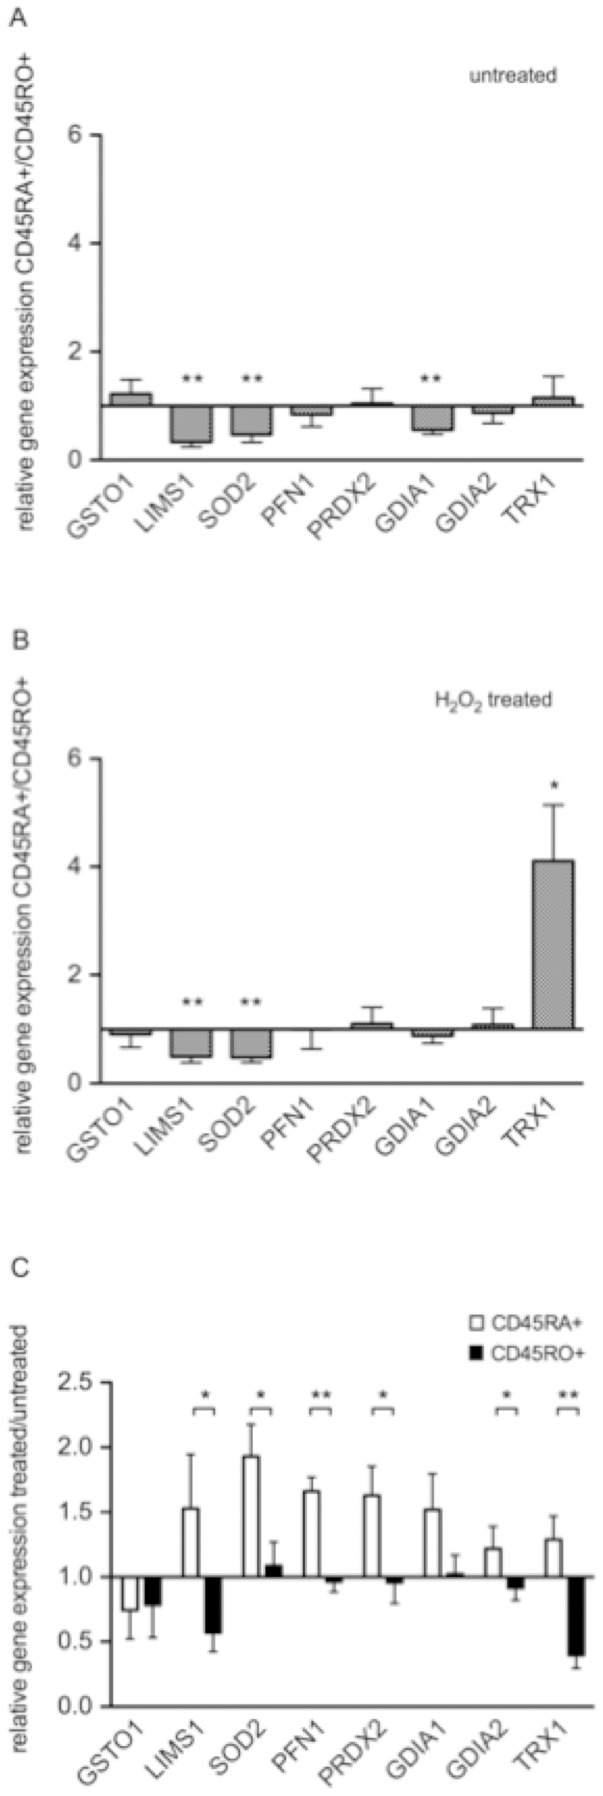
Comparative mRNA expression profiling for the selected panel of differentially expressed targets in the various T cell subsets.Up-/down-regulation of the relative gene expression levels for the selected members of differentially expressed target structures in (A) untreated CD45RA+ vs. untreated CD45RO+ T cells; (B) H2O2-treated CD45RA+ vs. H2O2-treated CD45RO+ T cells and (C) H2O2-treated vs. untreated naïve CD45RA+ (white bars) or memory/effector CD45RO+ (black bars) T cells (n = 6). T cells were either left untreated or treated with 5 µM H2O2 for 3 hours as described in the Materials and methods section. The error bars represent the given standard error of the mean values. P-values <0.05 are marked with a star, whereas p-values <0.01 are marked with 2 stars.